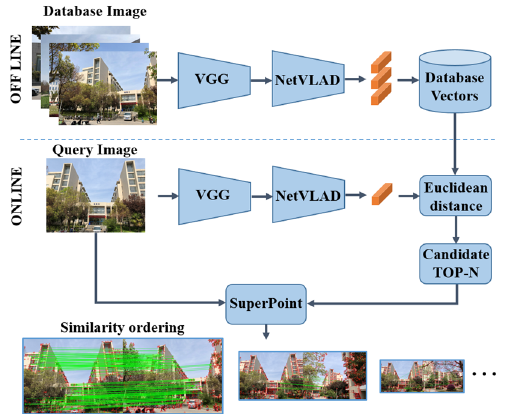
Figure 6. Solution B. Extracting global feature based on VGG16 and NetVLAD network for rapid preliminary searching, and then rearrange candidate images based on the results of SuperPoint feature matching.